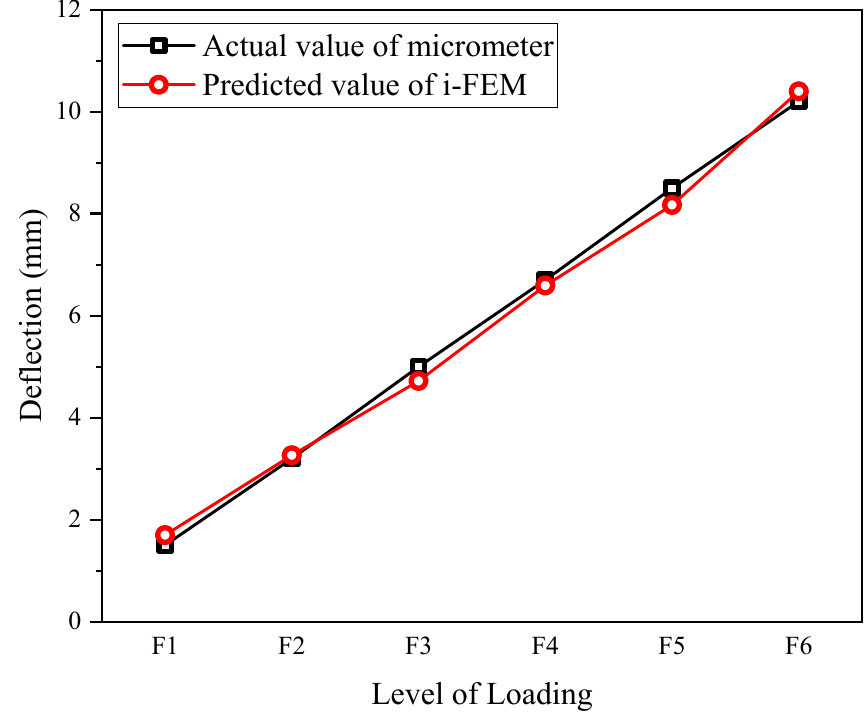
Figure 4. Results of calibration.